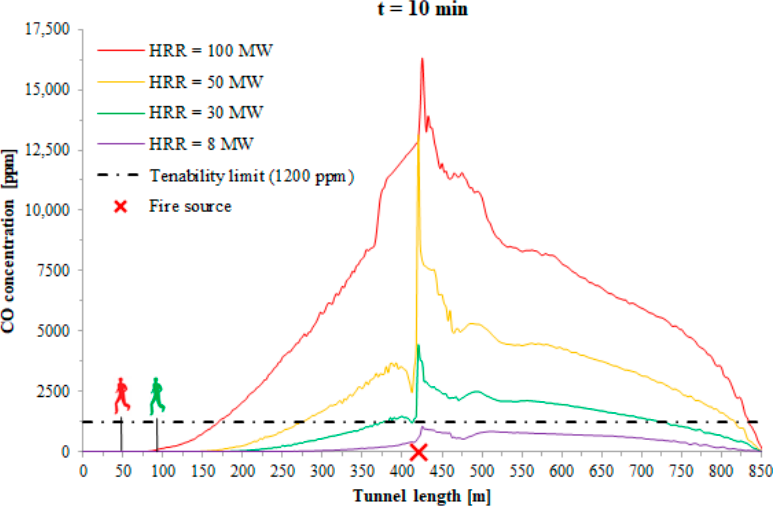
Figure 5. Longitudinal CO concentration profiles (t = 10 min) at a height of 2 along the escape path when the fire source is in the middle of the tunnel length.